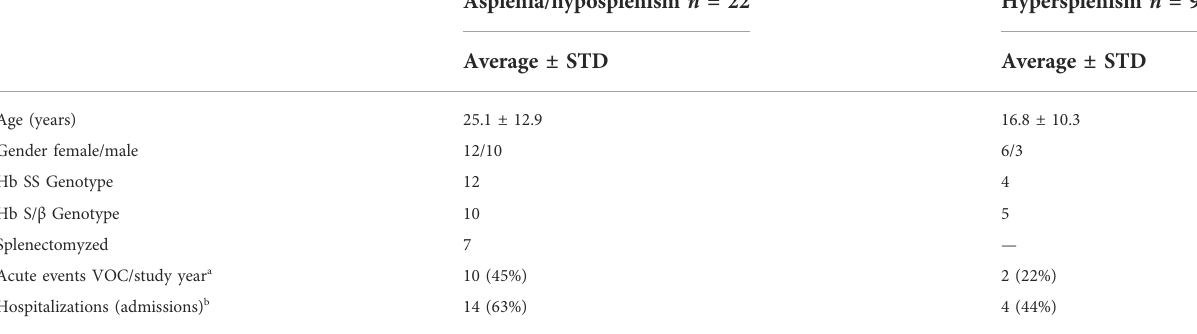
TABLE 1 Patients ’ characteristics. Demographic and clinical features of 31 SCD patients enrolled in this study and divided into two groups: Asplenia/ hyposplenism and Hypersplenism. Events of VOC and hospitalizations presented here are per year prior to the